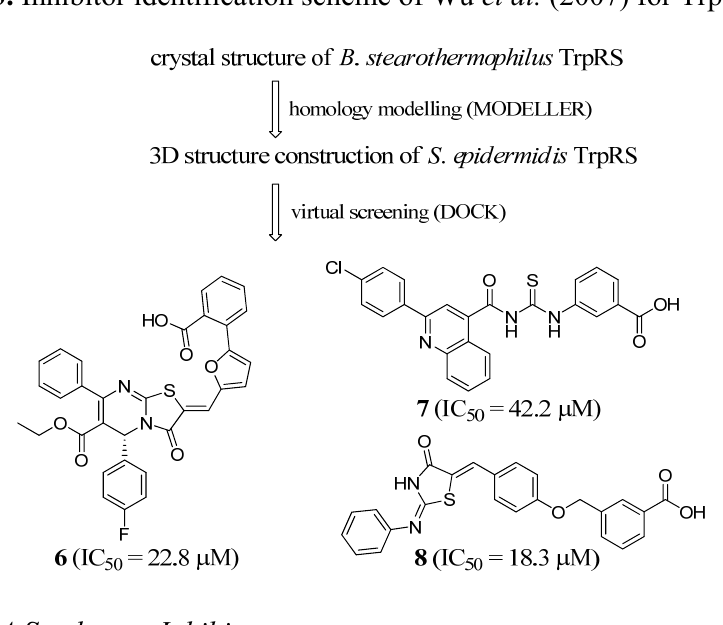
Figure 3. Inhibitor identification scheme of Wu et al. (2007) for TrpRS [43].